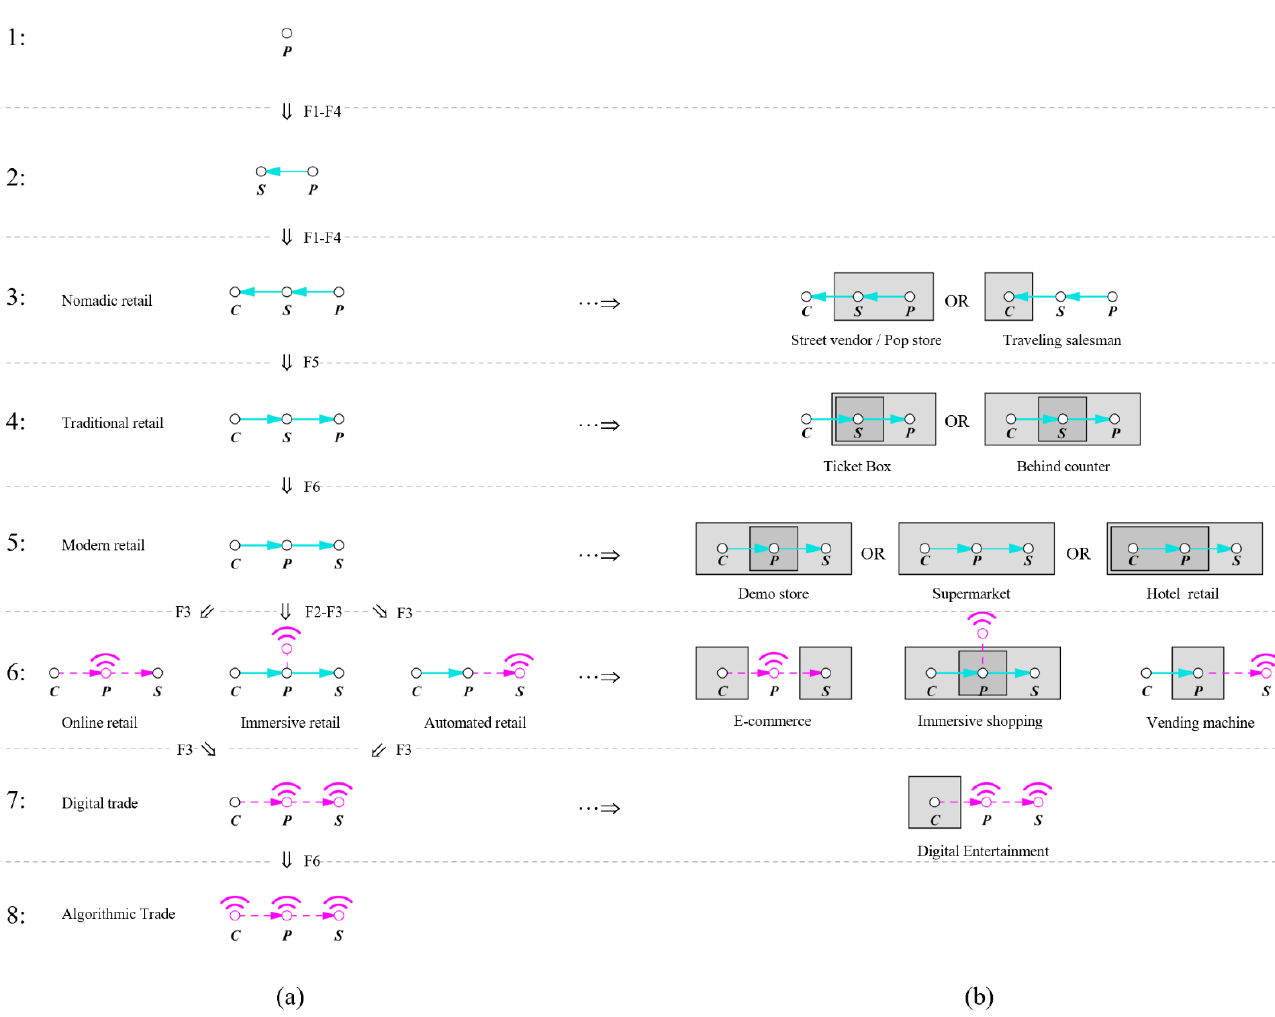
Figure 9. Different trade flow and retailing types produced from graph-to-graph iteration ( a ) and examples of spatial arrangement presented with diagrammatic sections ( b ). Nodes P = product, S = seller, and C = customer. The wi-fi symbols indicate a virtual function.